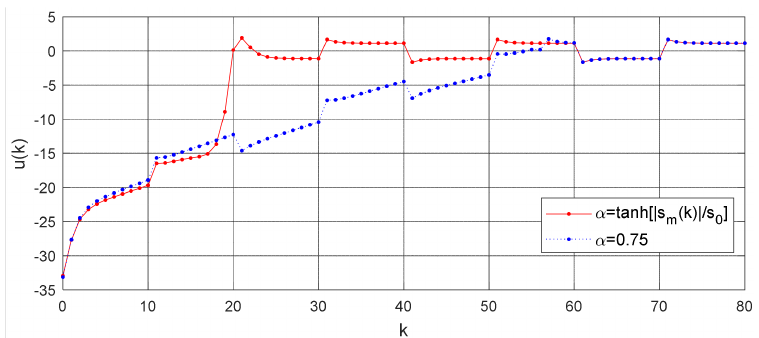
Figure 5. Sliding variable in the sliding phase.